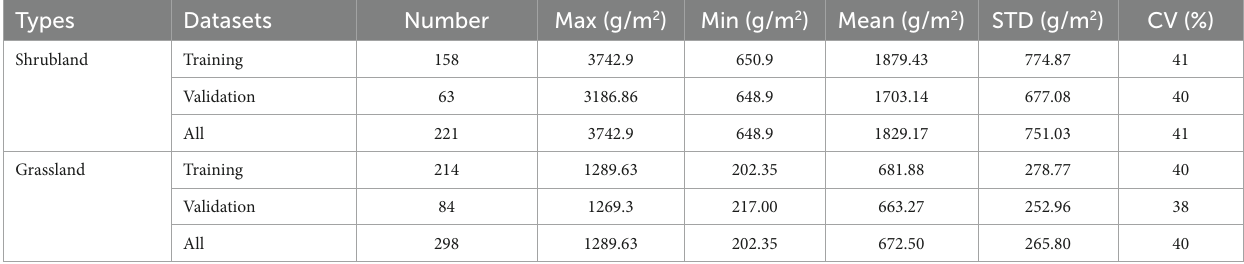
TABLE 2 The statistical descriptions of the measured AGB for the training set, validation set and all data of grassland and